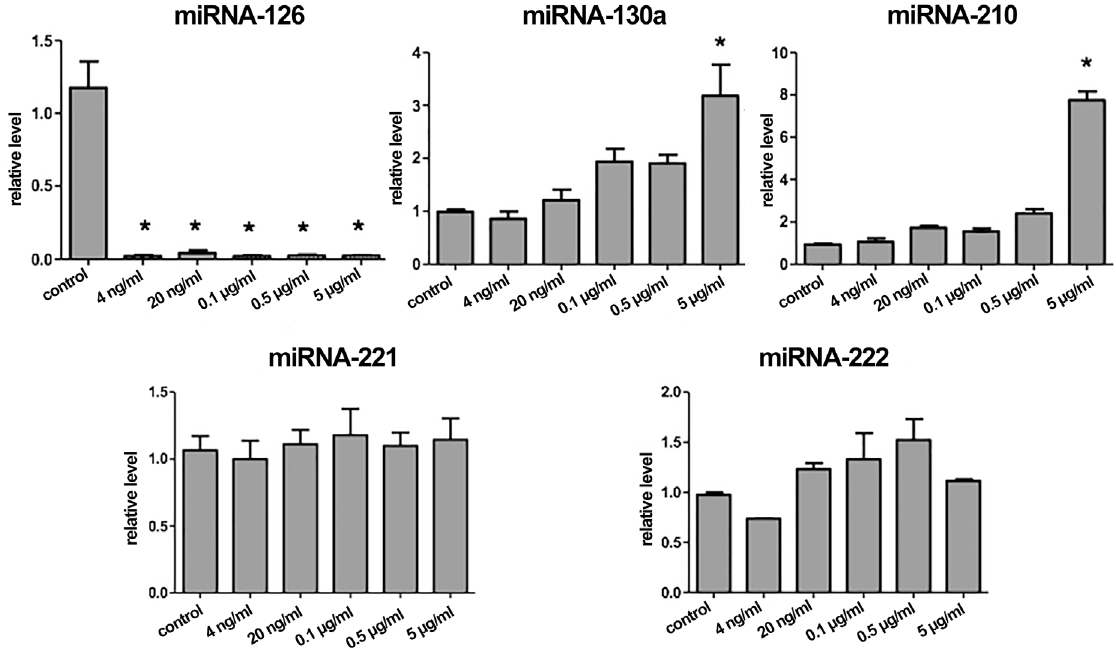
Figure 7 - Effects of different levels of ISMN on miRNAs expressions in HUVECs after 24 h treatment. Data were expressed as mean (cid:5) SD (n = 3). * p <